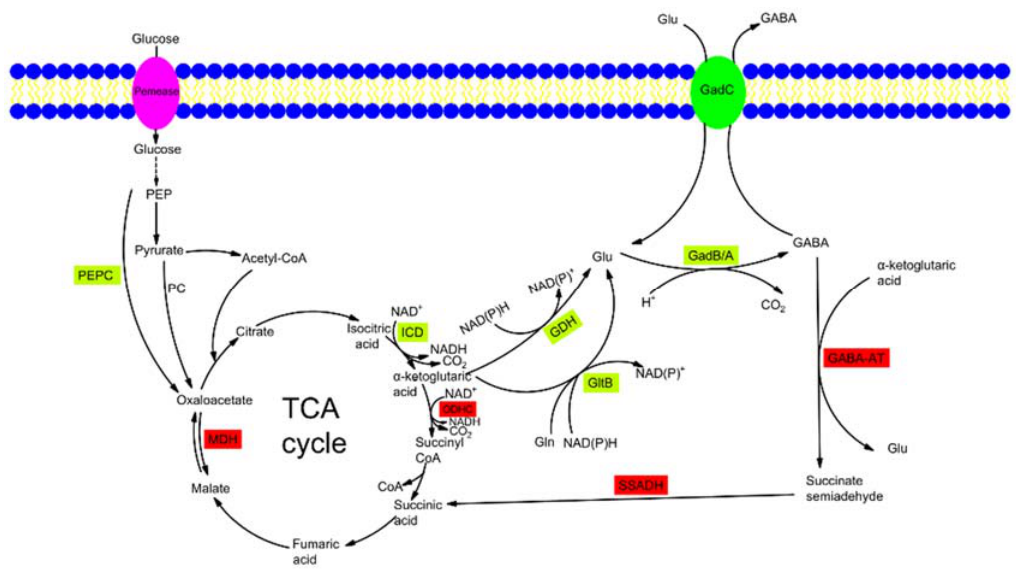
Figure 1. The biosynthetic pathway of GABA by microbes. GABA ‐ AT, GABA aminotransferase; GadB/GadA, glutamate decarboxylase; GadC, glutamate: γ‐ aminobutyrate antiporter; GDH, l -glutamate dehydrogenase; GltB, glutamate synthase; Icd, isocitrate dehydrogenase; MDH, malate dehydrogenase; ODHC, 2 ‐ oxoglutarate dehydrogenase complex; PC, pyruvate carboxylase; PEP, phosphoenolpyruvate; PEPC, phosphoenolpyruvate carboxylase; SSADH, succinate semialdehyde dehydrogenase; TCA cycle, tricarboxylic acid cycle. The expression of enzymes in green font will increase GABA production, and the expression of enzymes in red font will decrease GABA production.